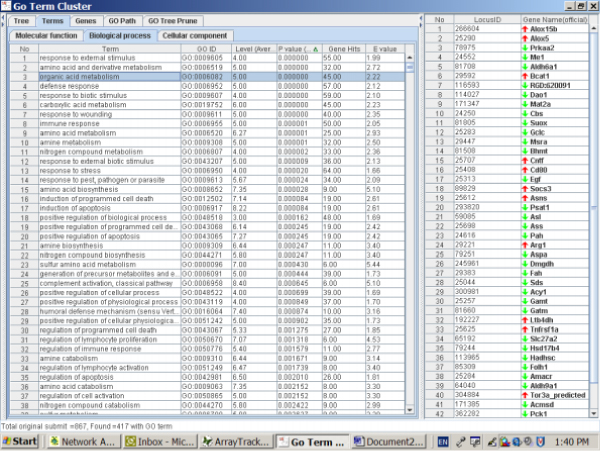
Significantly altered terms and the genes associated with organic acid metabolism caused by AA treatment in rat kidney. The left panel is the Terms Window and the right panel is the Genes Window. The major genes in the list were down-regulated.